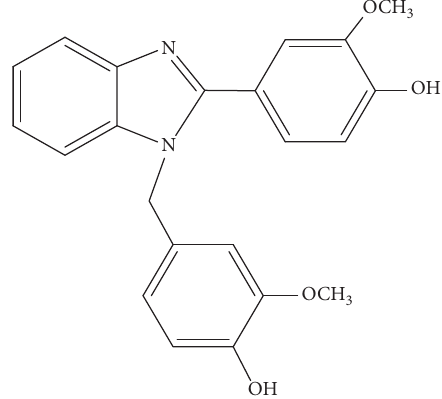
Figure 1: The benzimidazole compound ( L ) used in this